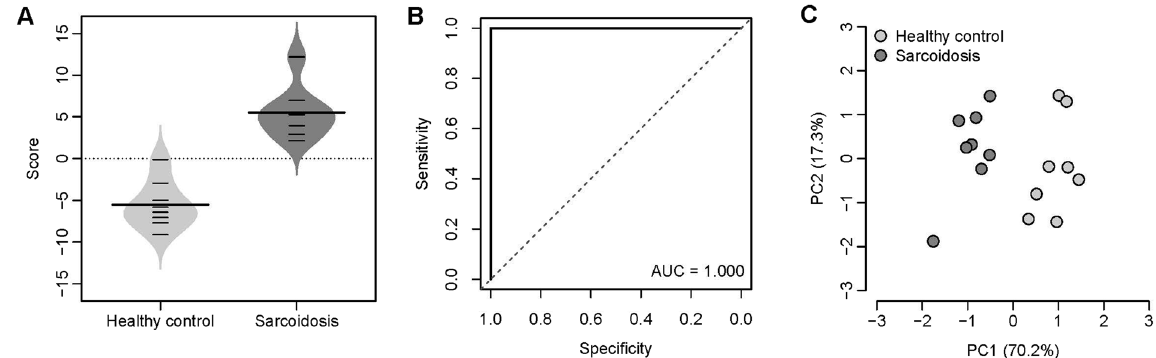
Figure 3. The performance of the 8-miRNA signature in the sarcoidosis validation cohort. ( A ) The 8-miRNA signature based severity score differentiates the sarcoidosis patients from the healthy controls in the Berlin cohort. The violin plot indicates the distribution of the severity score in each category. ( B ) The ROC curve of the 8-miRNA signature in classifying the subjects in the Berlin cohort. The AUC is equal to one. ( C ) Principal component analysis on the expression of the 8-miRNA signature. X-axis: the first principal component with eigenvalue; Y-axis: the second principal component with